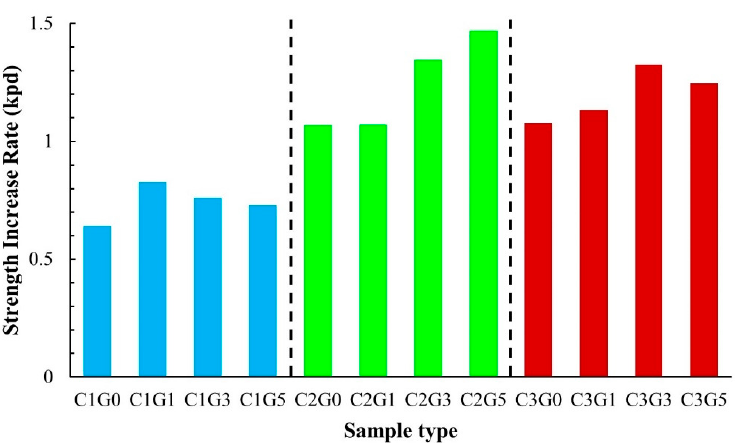
Figure 11. Strength increase rate (SIR) of all mixtures in this study.